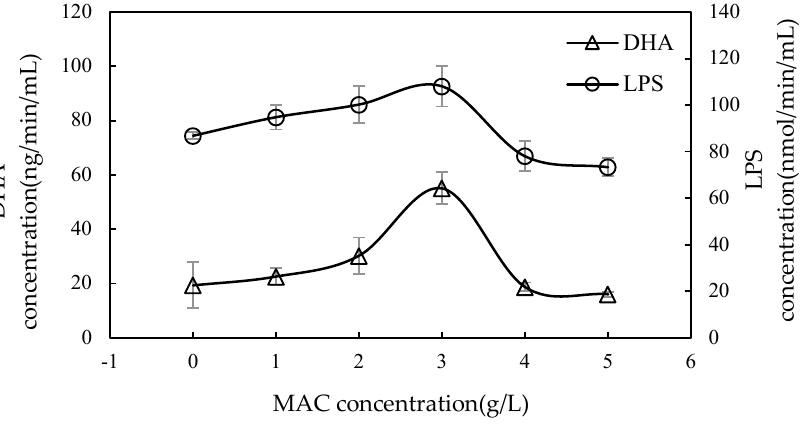
Figure 4. Effects of the added MAC concentration on the DHA and LPS values of bacteria (experimental conditions: MAC mass: 0–3 g/L; solution volume: 100 mL; temperature: 30 °C; pH = 7; time: 15 days; rotating speed: 150 r/min)